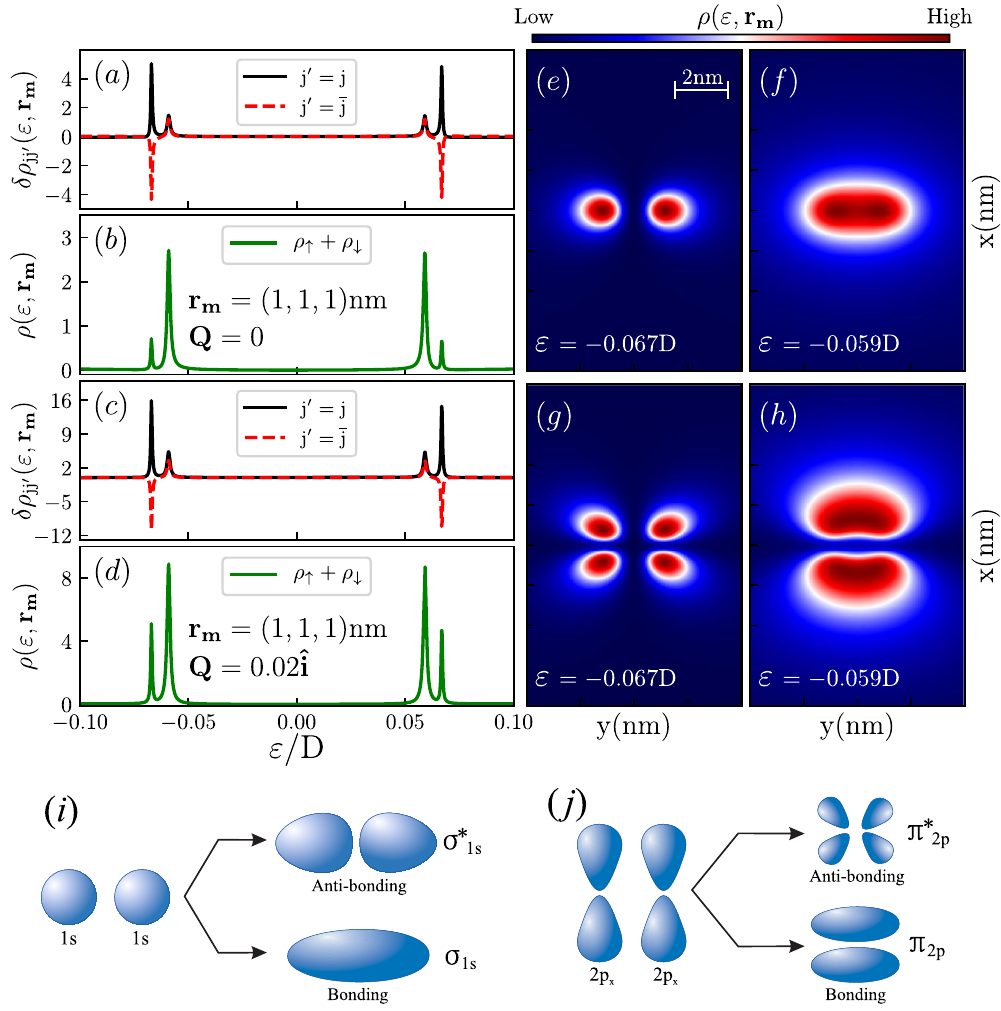
Figure 3. LDOS for a pair of impurities. The panels (a,b,e,f) correspond to the case of Dirac semimetal ( Q = 0), the panels (c,d,g,h) to the case of  -breaking Weyl semimetal with ⋅ = Q r 0 . Panels (a and c) display the 12 diagonal ( δρ ) and off-diagonal ( δρ ) contributions to the LDOS. Note that δρ reveals both dips and peaks jj jj jj δρ reveals peaks only. The total LDOS is corresponding to anti-resonances and resonances respectively, while jj presented in the panels (b and d). We set = r (1, 1, 1) nm , the energy is counted from the Fermi level set at m = 0, for the Weyl host Q = 0.02. The total LDOS on the = x y r ( , , 1) nm ε surface for the energies of bonding F x m and antibonding states ( ε = − . D 0 067 and D 0 059 ε = − . ) is shown in panels (e,f,g,h). Panels (i and j) illustrate how molecular orbitals presented in the panels (e–h) are formed from atomic orbitals presented in the Fig.